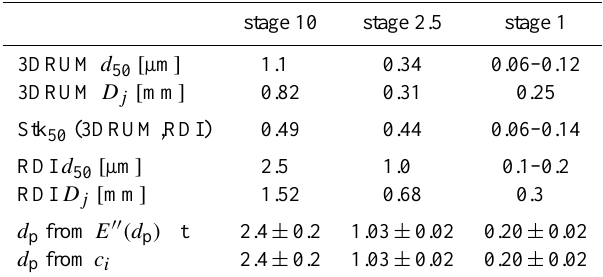
Table 1. Values of characteristic parameters of 3DRUM and RDI as well as penetration midpoint diameters in µm (aerodynamic diame- ter) calculated from the second derivative E 00 (cid:0) d p (cid:1) of the sigmoidal fit for RDI stages 10, 2.5, and 1. The free parameter c i of the sig- moidal fit, which is an equivalent way to obtain the inflection point, is listed as well.